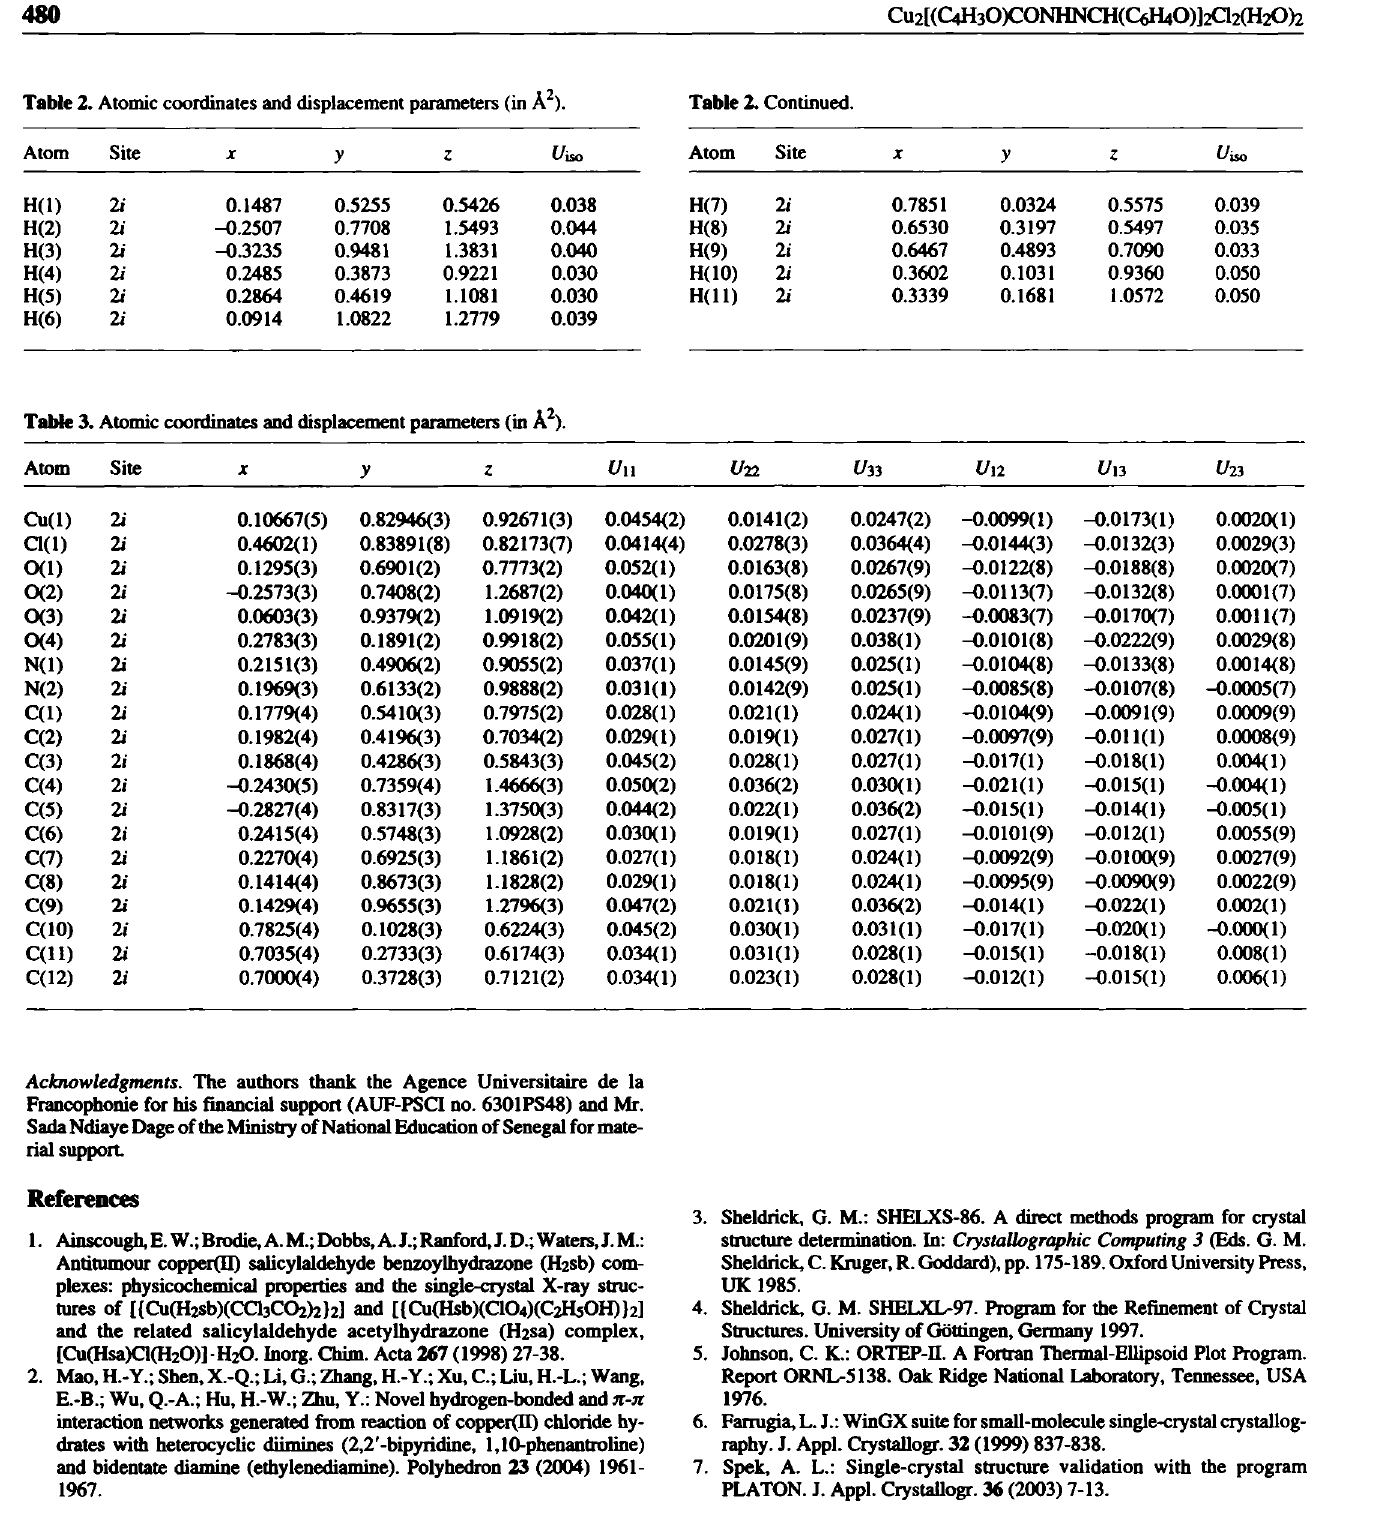
Table 3. Atomic coordinates and displacement parameters (in A 2